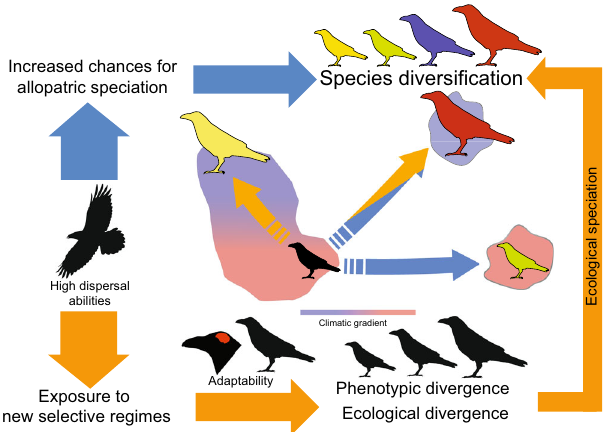
Fig. 1 Conceptual depictions of the contributions of dispersal abilities and adaptability in (global) diversi fi cations. Increased capacity to disperse over long distances creates more frequent opportunities for allopatric speciation (blue arrows) and exposes lineages to new environments (orange arrows). Traits that facilitate survival and local adaptation under suboptimal conditions prevent local extinction upon arrival and give lineages the opportunity to evolve in response to optimising selection from the new environmental conditions. These adaptive processes further increase the chances of diversi fi cation through ecological